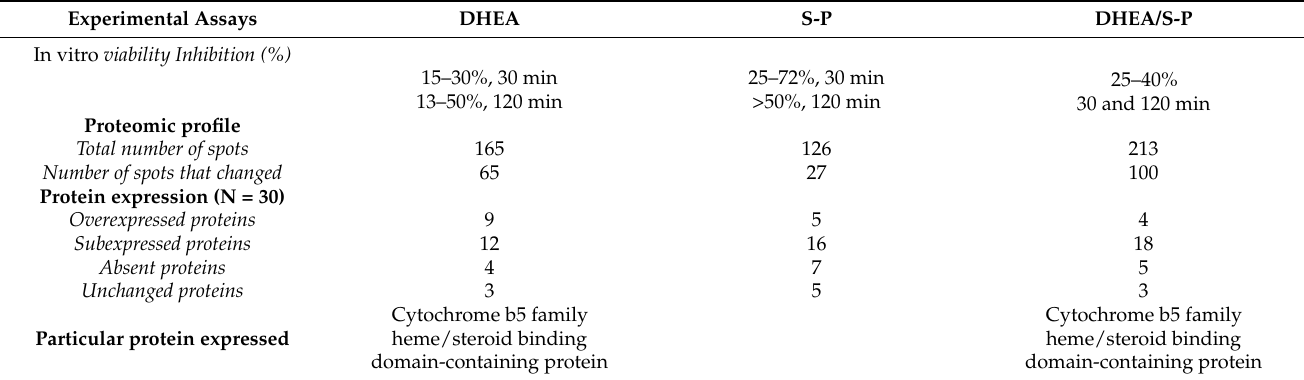
Table 3. Summary of all changes induced by DHEA, S-P, and DHEA/S-P treatments in Toxoplasma gondii in vitro and in